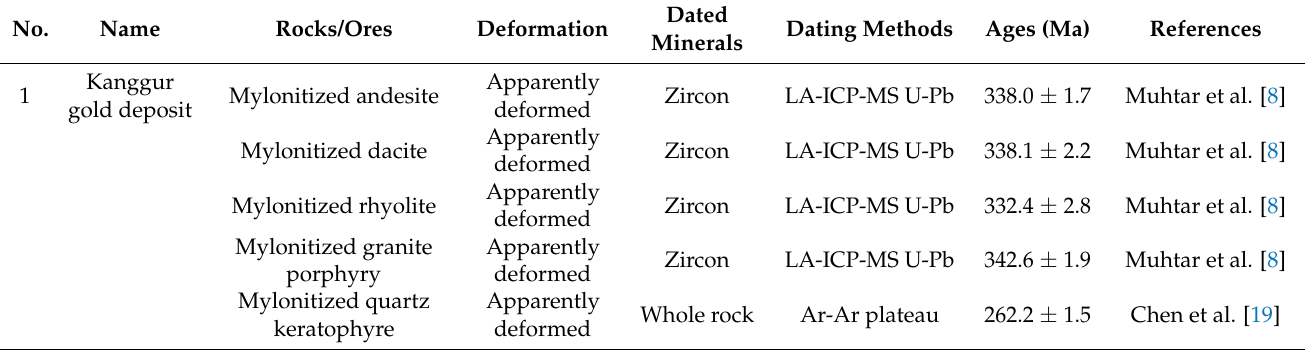
Table 8. Isotopic ages of typical tectono- magmatism in Eastern Tianshan.